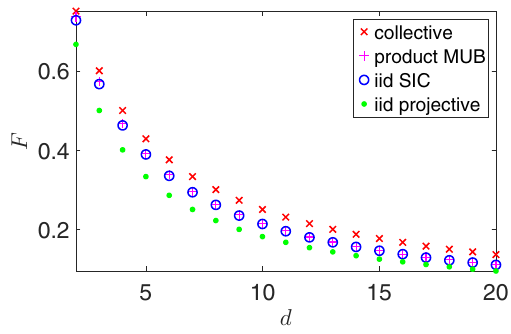
FIG. 3. Two-copy estimation fidelities achieved by optimal collective measurements, optimal product measurements (based on MUB), and optimal independent and identical measurements (based on SICs). As a benchmark, the figure also shows the estimation fidelity achieved by independent and identical rank-1 projective